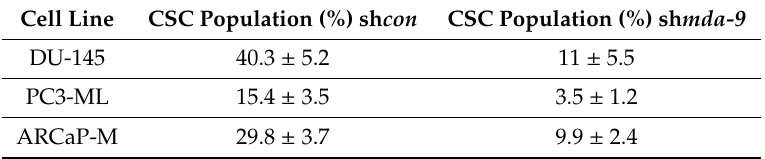
Table 2. E ff ect of mda-9 expression on CSC populations in prostate cancer cells.